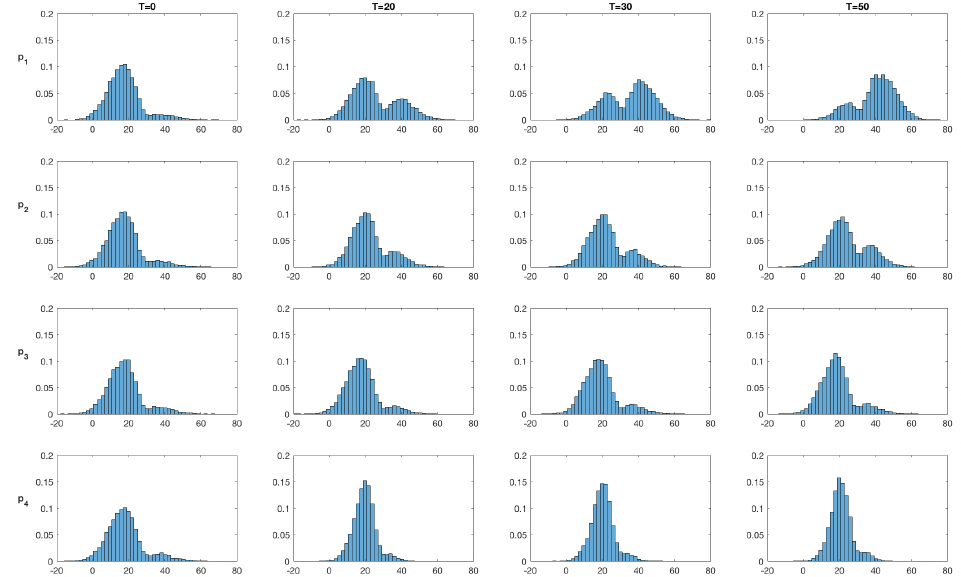
Figure 16. SEnKS approach: Marginal posterior distributions of the initial temperature f ( r 0, i | d 0: T ) at time T = 0,20,30,50 at monitoring locations ( i = 1,2,3,4) denoted ( p 1 , p 2 , p 3 , p 4 ). The horizontal axes representing temperature are expressed in ◦